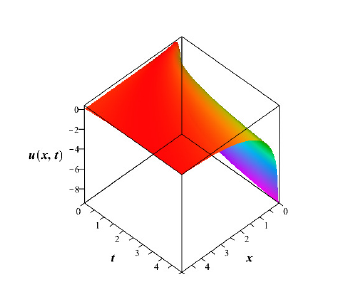
Figure 6. The shape function of Figure 7. The complete solution of the pink noise for a = λ = ν = 1 and the KPZ equation for the pink noise for c 1 = 1 and c 2 = 0 . with the parameters given